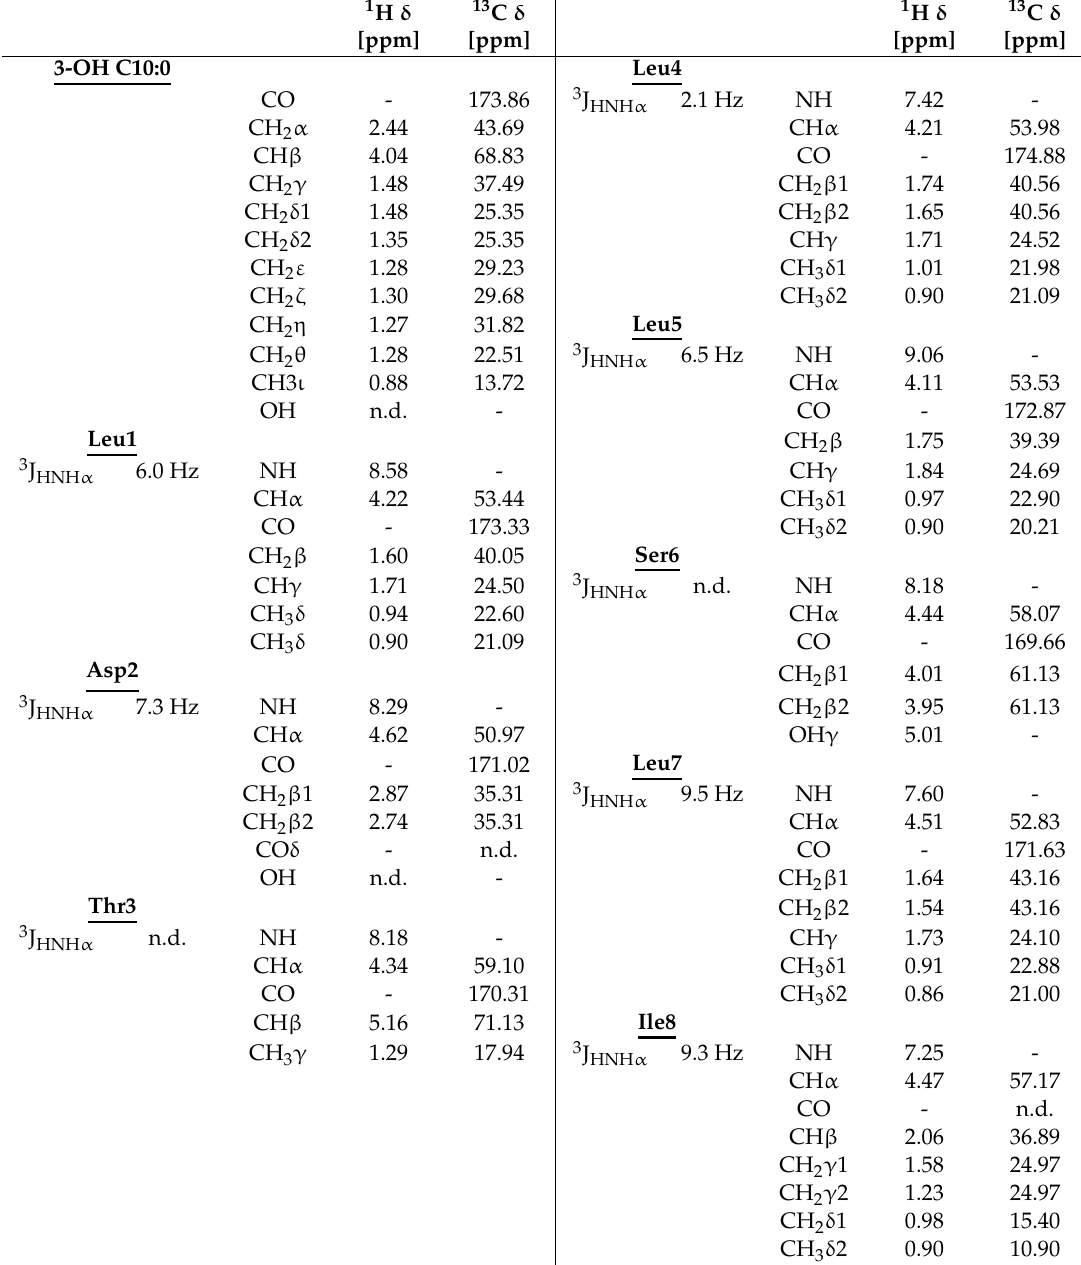
Table A3. 1 H and 13 C chemical shift of ‘bananamide F’ at retention time 10.3 min, in DMF-d7 (298 K, 500